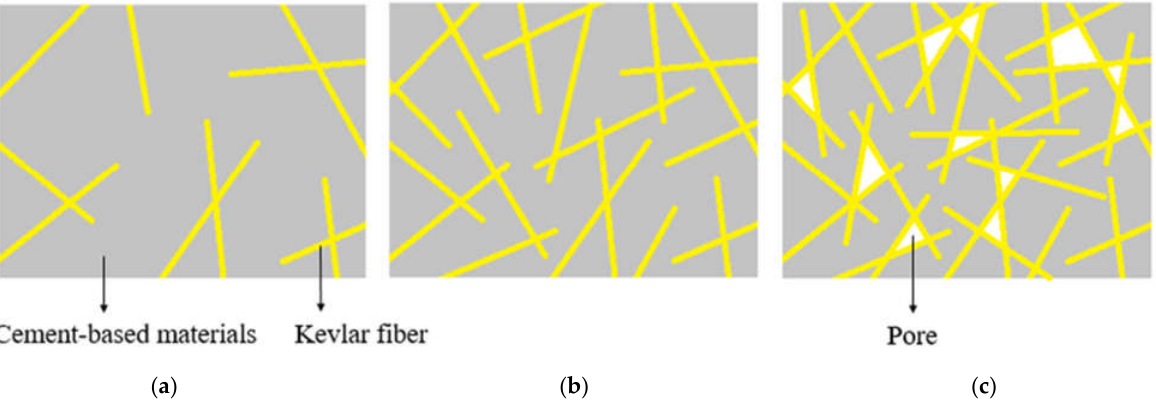
Figure 5. Illustrations of fiber distribution into the concrete specimens: ( a ) low fiber content; ( b ) optimal fiber content; ( c ) high fiber content.